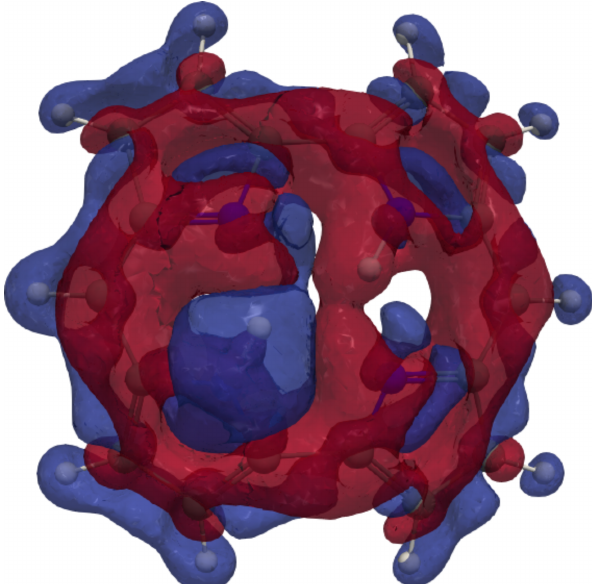
Figure 10. The isotropic 1 H NMR shielding density of the inner hydrogen of trans -norcorrole. The shielding contributions are shown in blue and the deshielding contributions in red. An isovalue of ± 0.04 has been used. The corresponding pictures of the 1 H NMR shielding densities of the meso and β hydrogen atoms are given in the